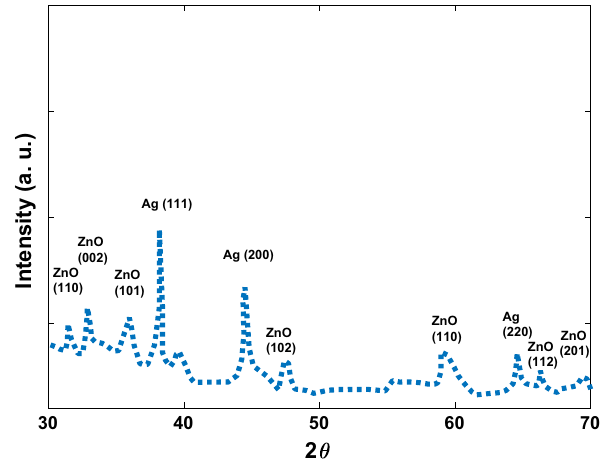
Figure 4. The XRD pattern of the synthesized NPs.